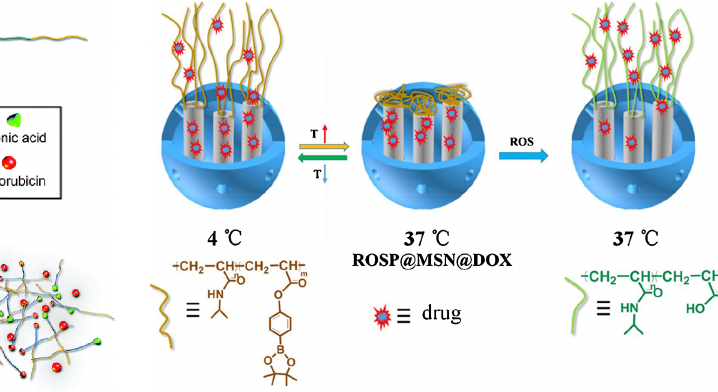
Figure 23: Schematic illustration for the temperature and H 2 O 2 - responsive behaviors of ROSP@MSN@DOX nanoparticles in